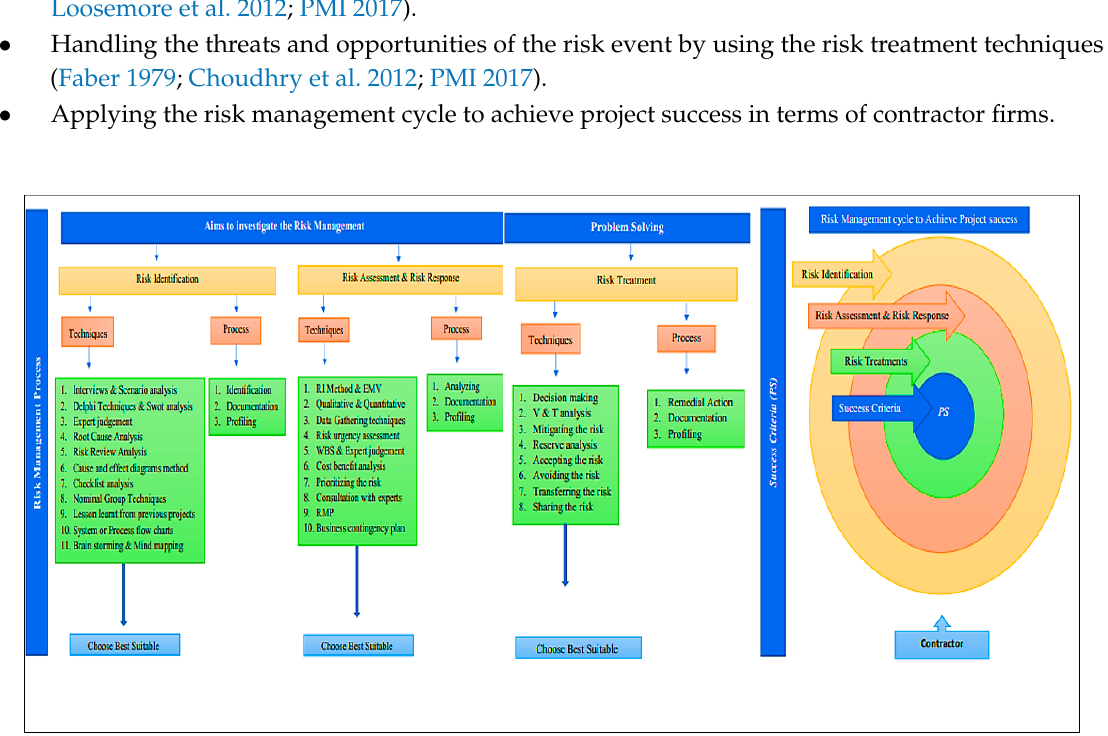
Figure 1. Proposed Risk Management Framework for the Construction industry.